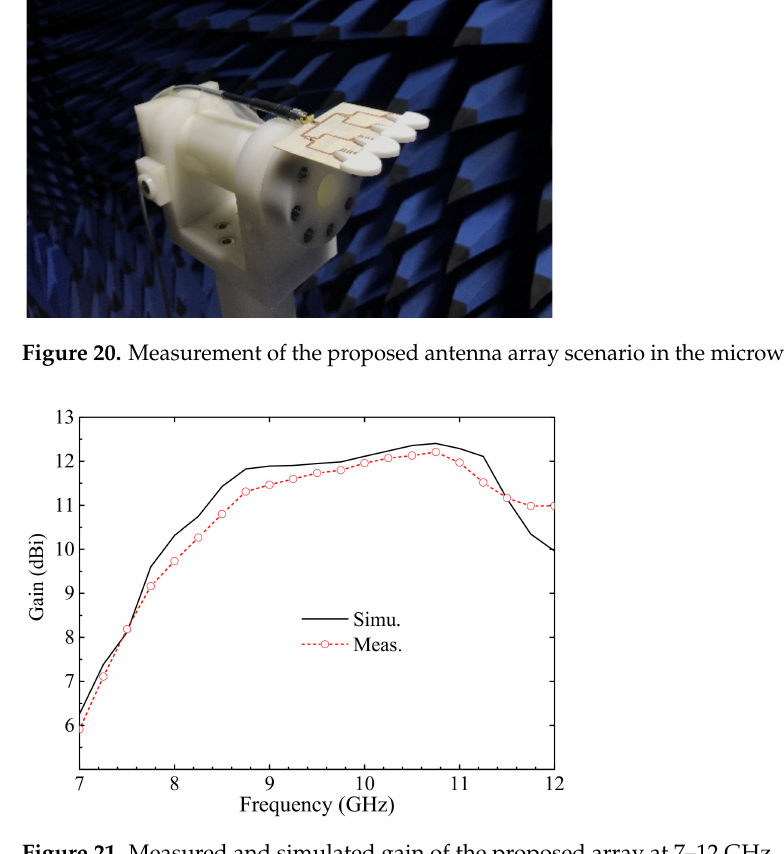
Figure 21. Measured and simulated gain of the proposed array at 7–12